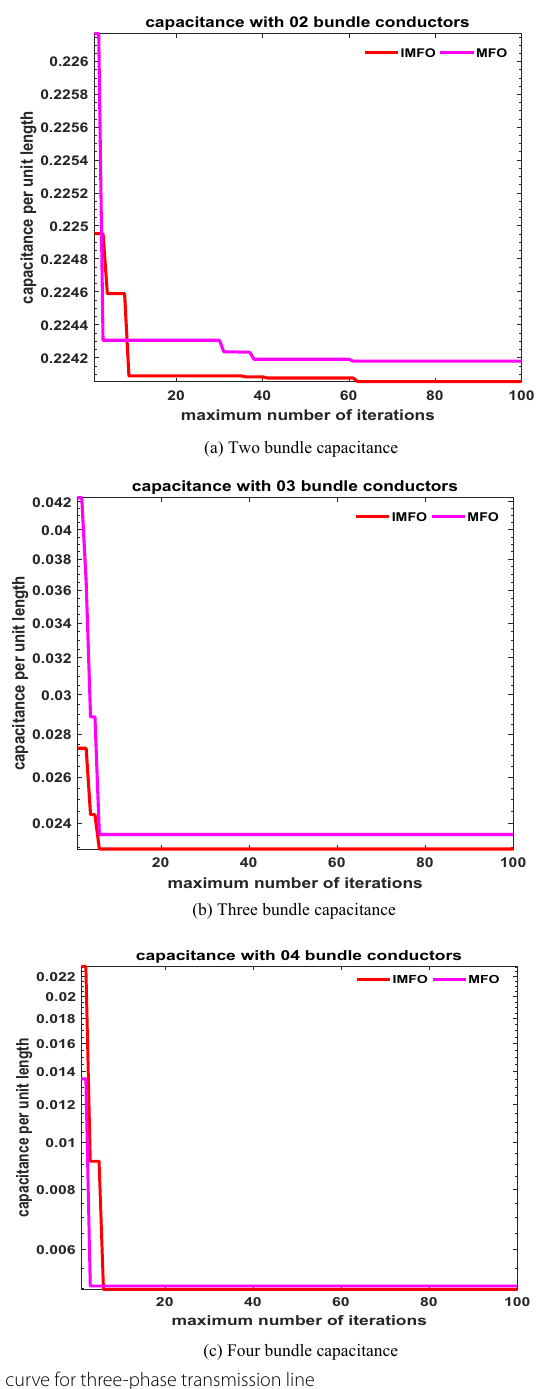
Fig. 3 Convergence curve for three-phase transmission